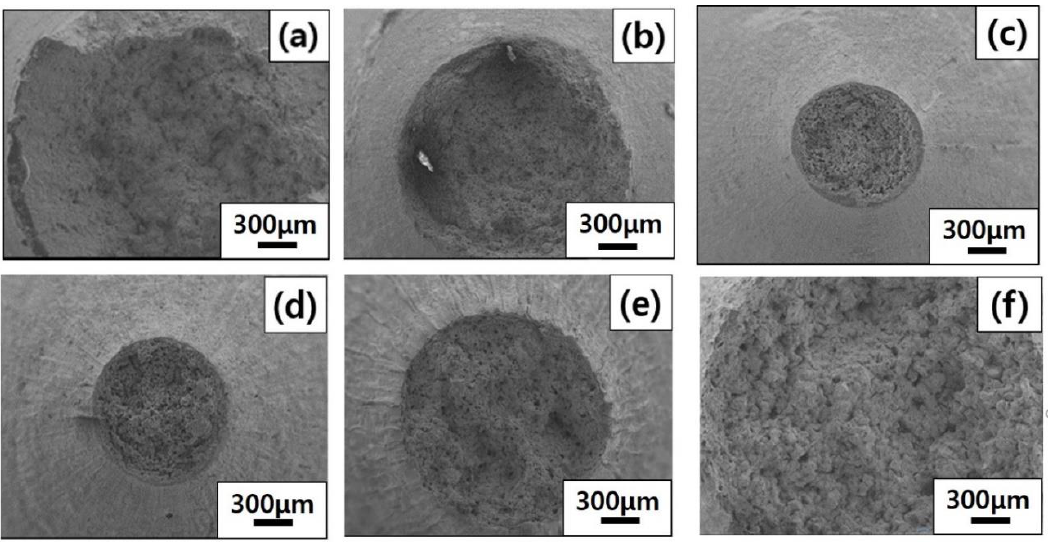
Figure 10. Fracture surfaces of Fe-Cr-Mn-Ni austenite stainless steel fractured at 850 ◦ C ( a ), 1000 ◦ C Figure 10 Fracture surfaces of Fe-Cr-Mn-Ni austenite stainless steel fractured at 850 °C ( a ), 1000 °C ( b ), 1100 ◦ C ( c ), 1150 ◦ C ( d ), 1200 ◦ C ( e ), and 1225 ◦ C ( f ( b ), 1100 °C ( c ), 1150 °C ( d ), 1200 °C ( e ), and 1225 °C ( f ).